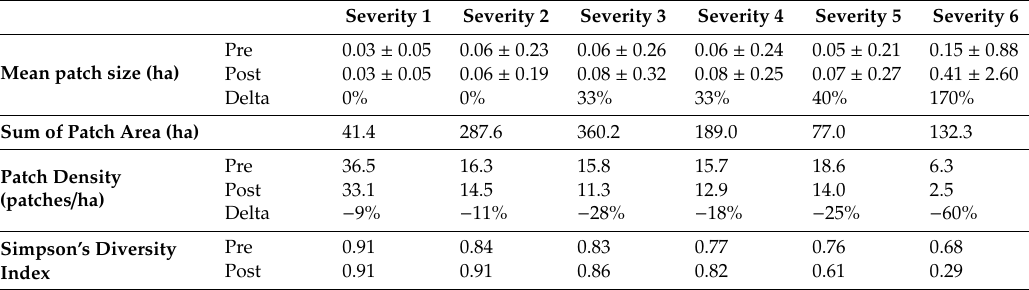
Table 6. Landscape pattern metrics stratified by burn severity